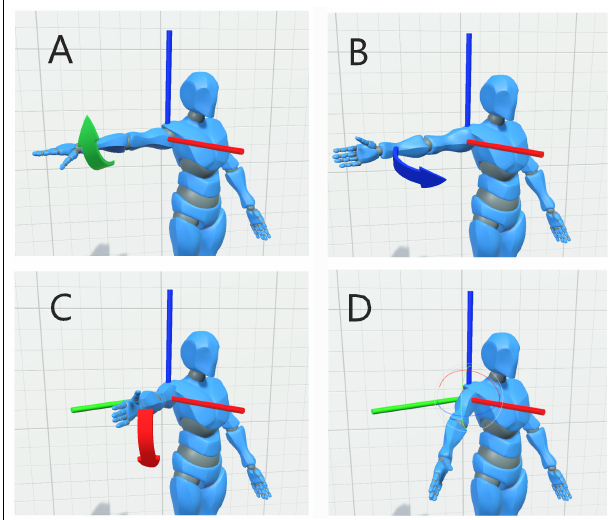
Figure 5. The combination of three angular rotations (A,B,C) can produce any position for the Right Shoulder articulation (D). normalization.